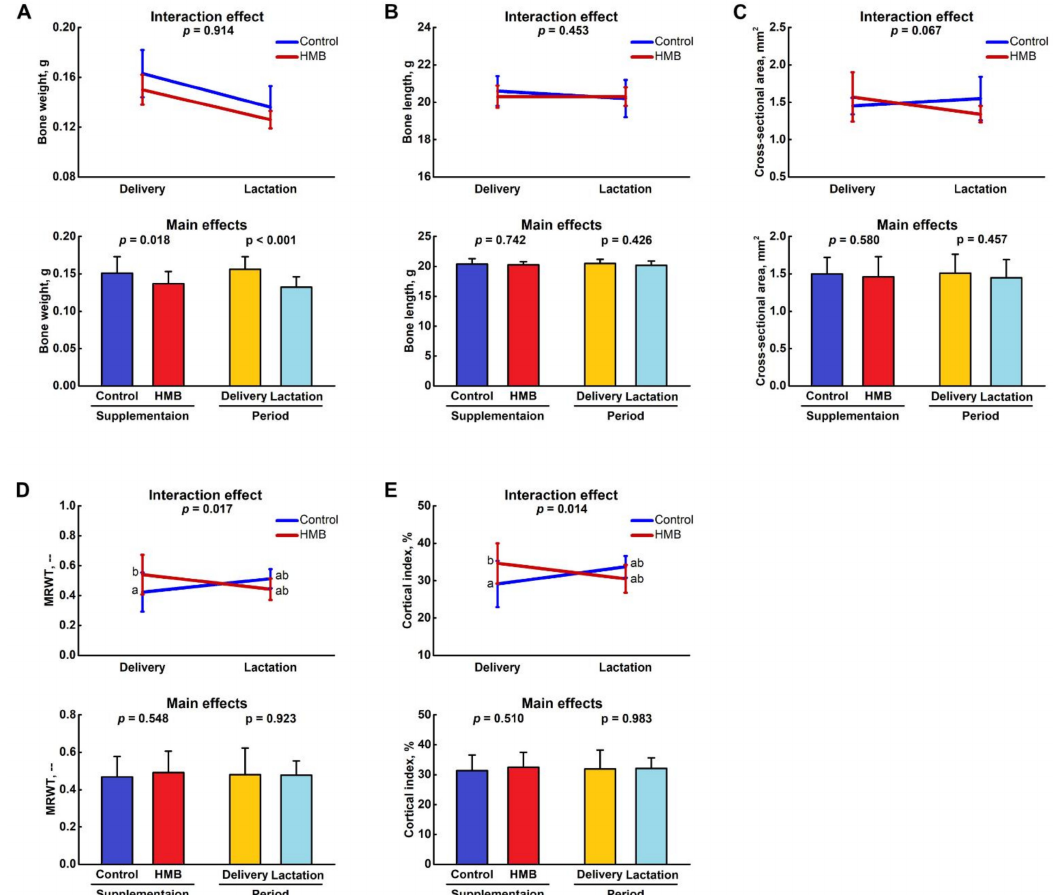
Figure 1. Effect of HMB supplementation (0.02 g/kg b.w.) during the middle trimester of pregnancy (13–26 d) on ( A ) weight, ( B ) length of femora as well as bone mid-diaphysis ( C ) cross-sectional area, ( D ) mean relative wall thickness (MRWT) and ( E ) cortical index of femora of spiny mice at delivery or after the lactation period. Figure shows LSMeans ± standard deviation as well as p -values of a two-way ANOVA with the supplementation (control, HMB) and period (delivery, lactation) and their interaction as fixed effects. Means with different letters in interaction effect plots differ significantly (Tukey’s post-hoc